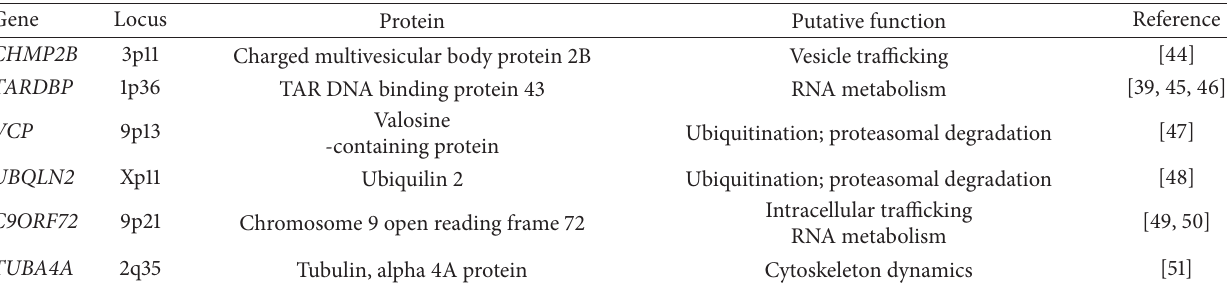
Table 1: Genes associated with both ALS and FTD.